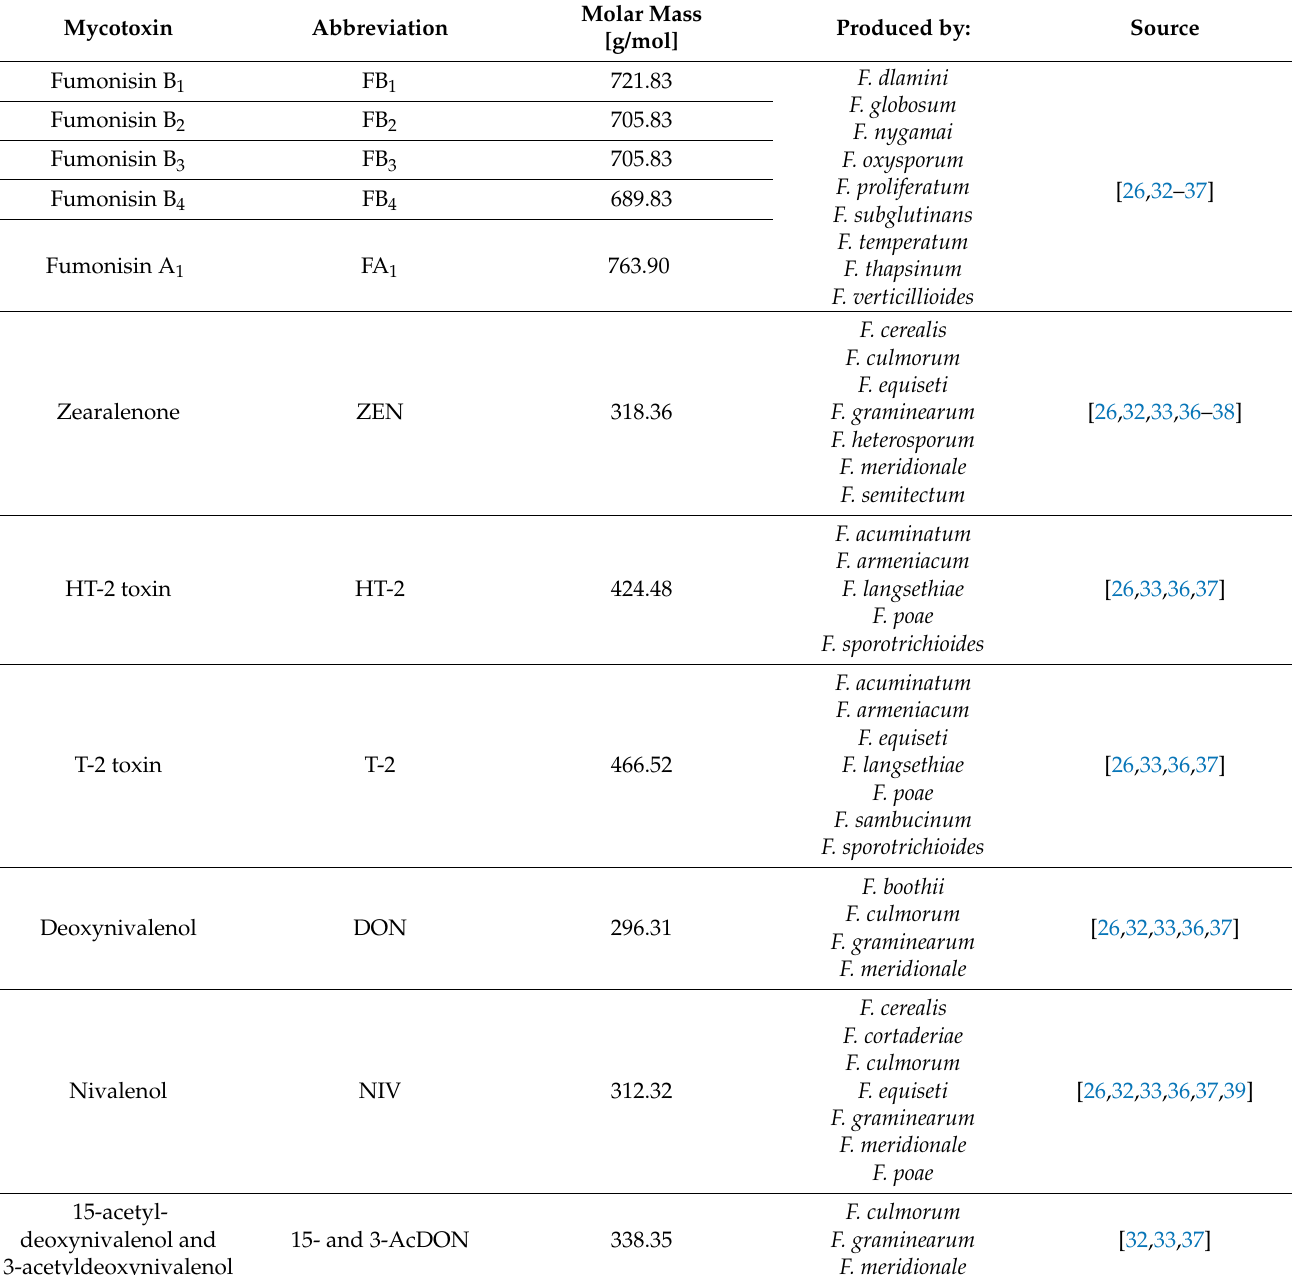
Table 1. Important mycotoxins and Fusarium species responsible for their biosynthesis in maize